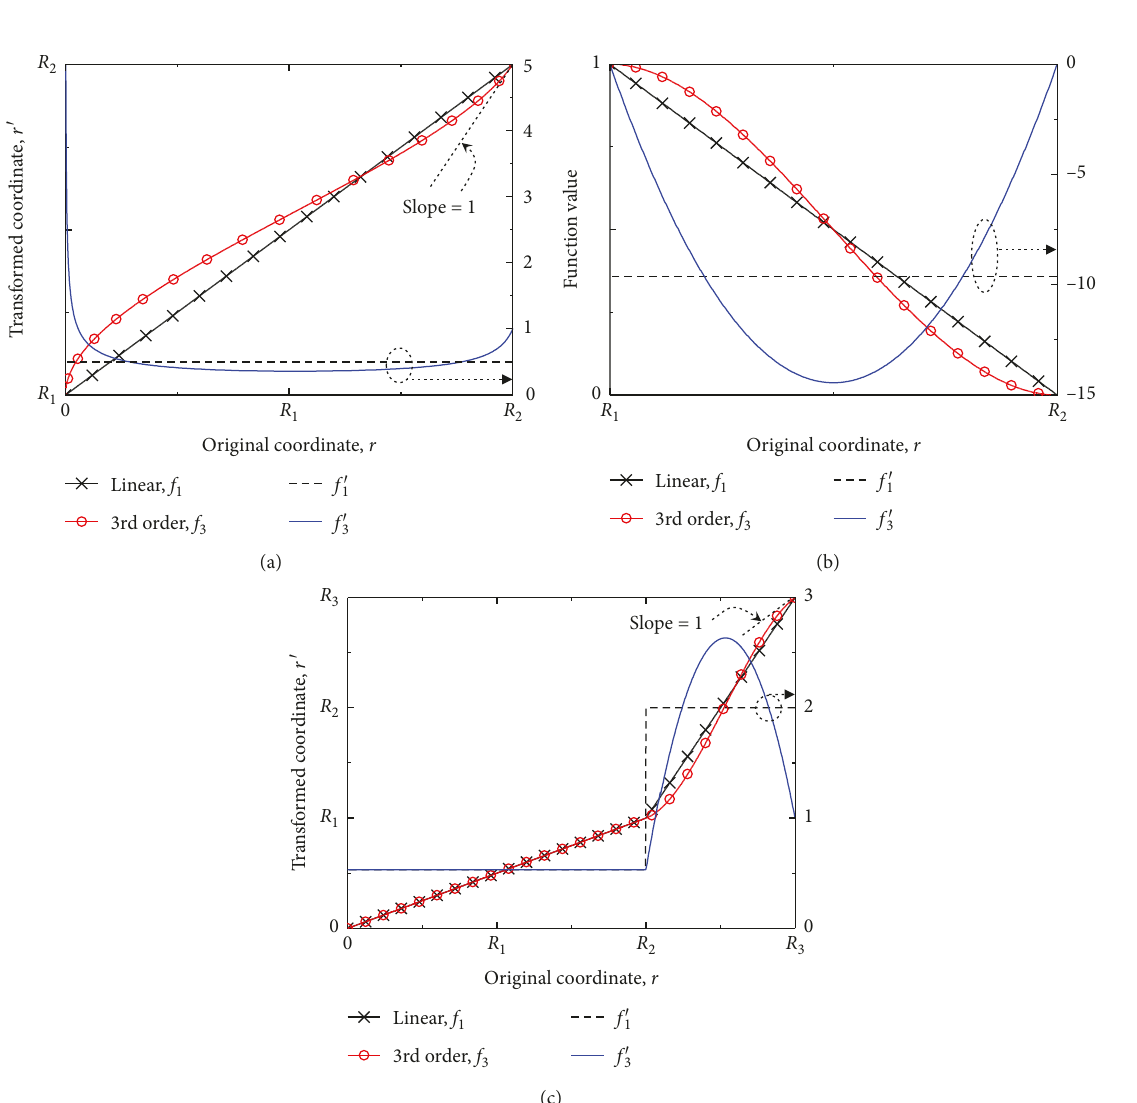
Figure 2: Transformation functions: (a) the cloak, (b) the rotator, and (c) the concentrator.